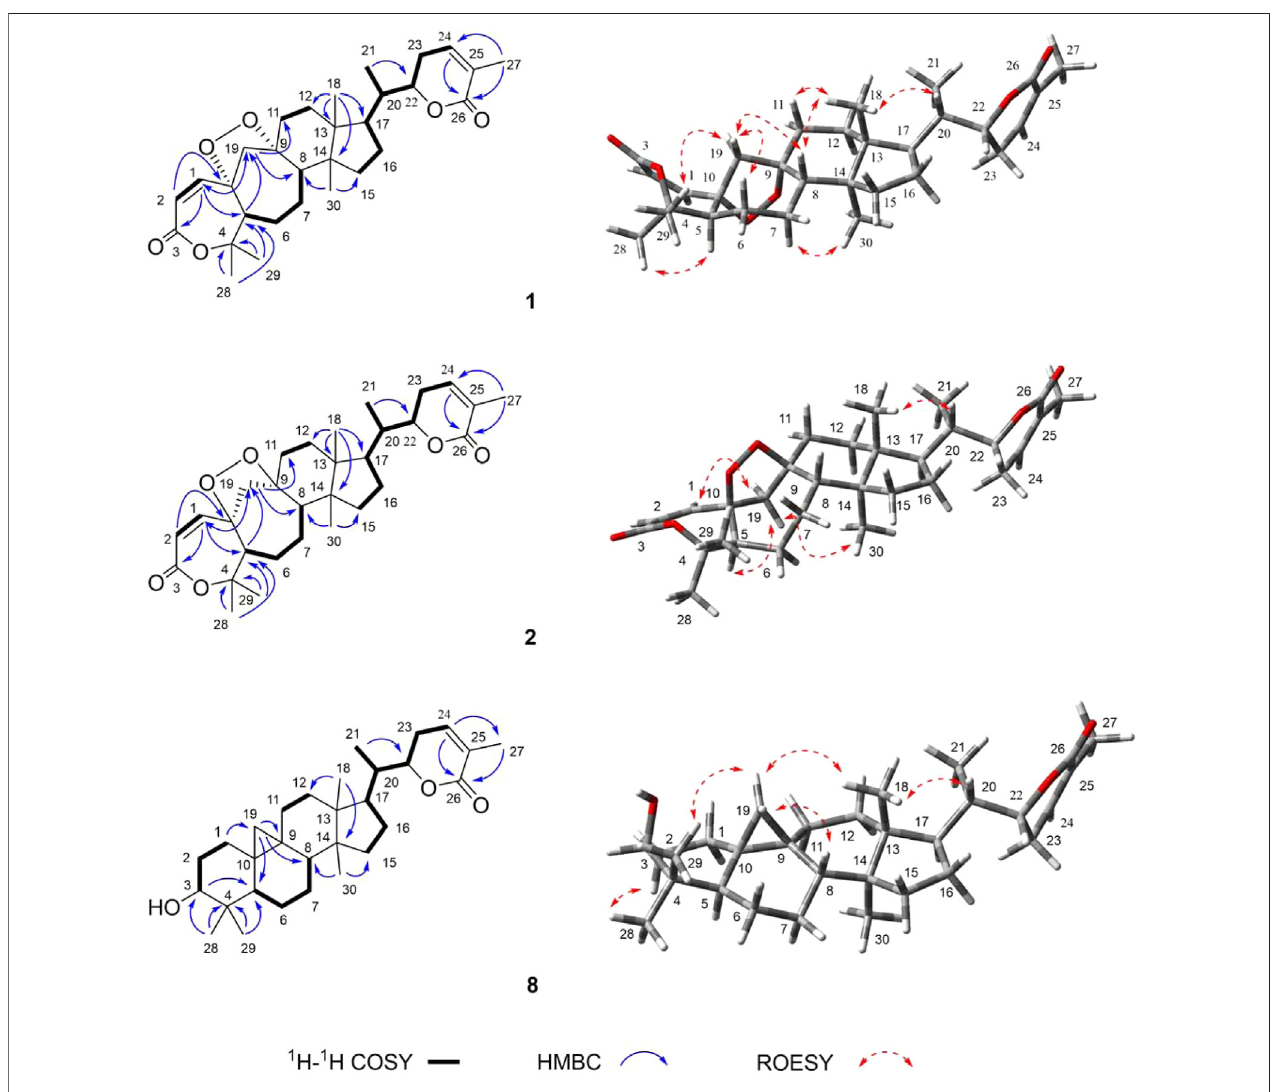
FIGURE 2 | Key 1 H – 1 H COSY, HMBC, and ROSEY correlations of 1, 2 , and 8 .